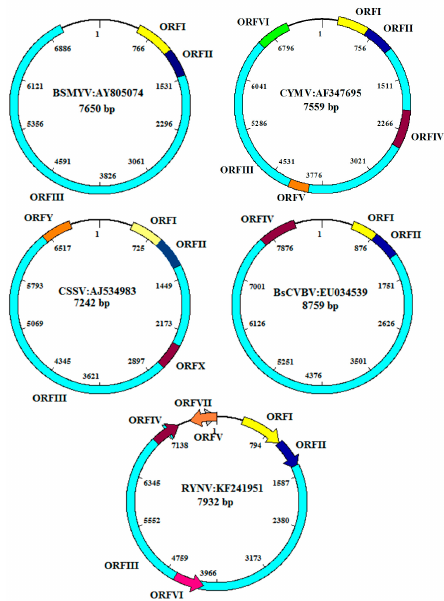
Figure 5. Genome organization of representative badnaviruses with varying number of open reading frames. BSMYV, Banana streak MY virus ; BsCVBV, Bougainvillea spectabilis chlorotic vein banding virus ; CSSV, Cacao swollen shoot virus ; CYMV, Citrus yellow mosaic virus ; RYNV, Rubus yellow net virus .